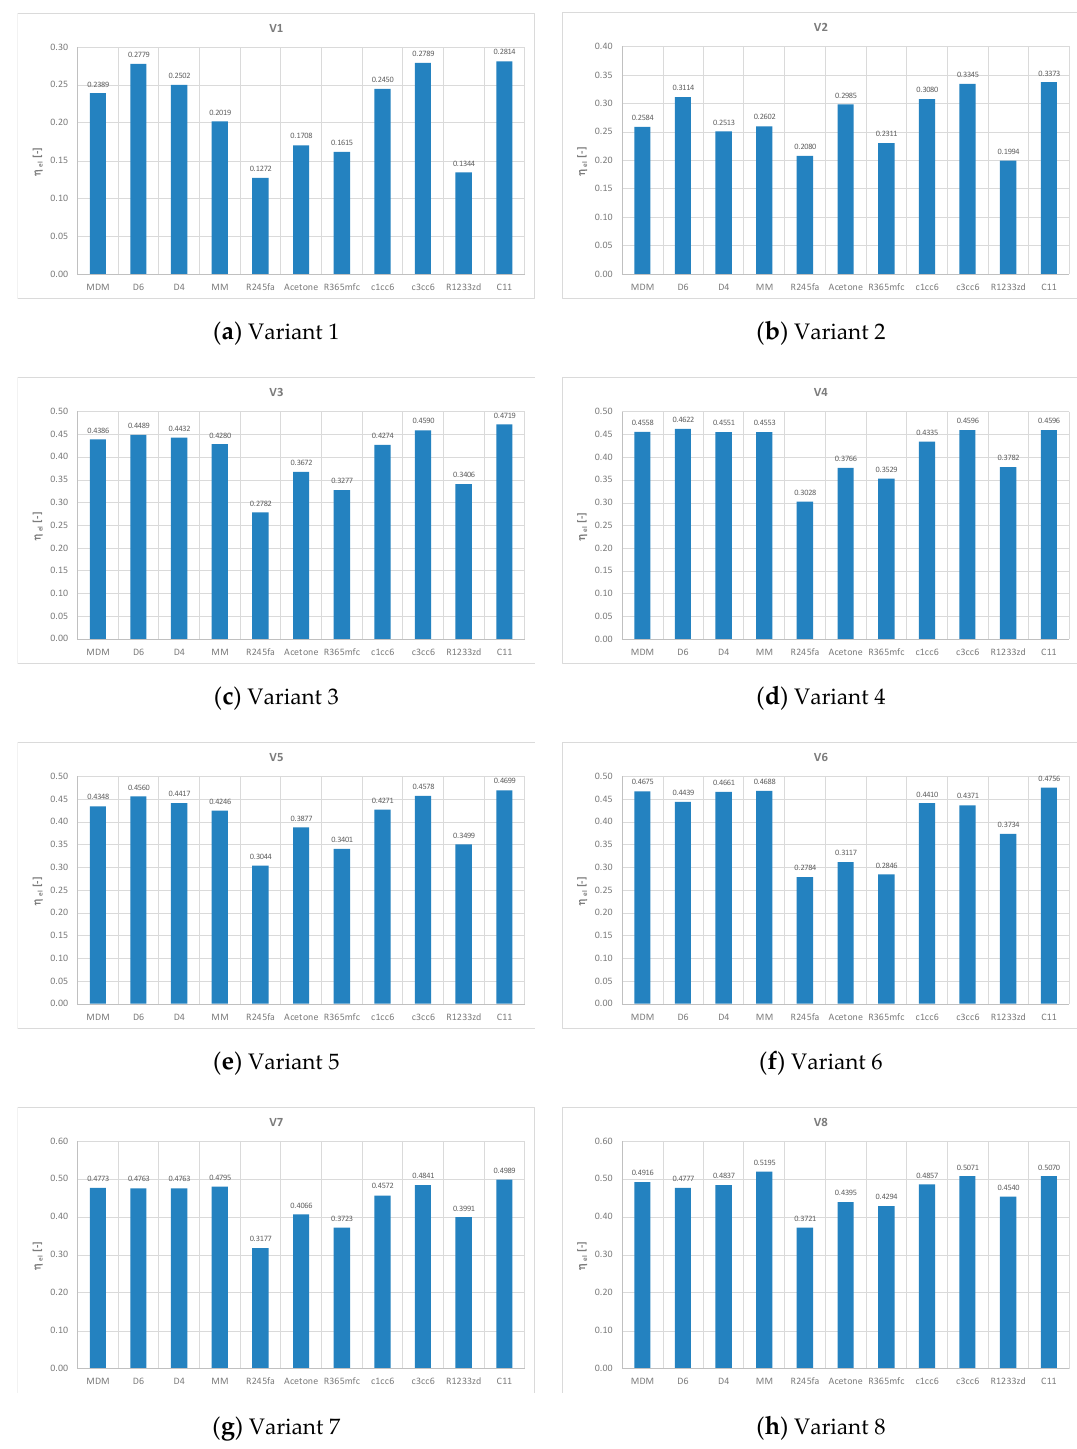
Figure 8. Overall efficiency for different working media: (a) Variant 1; (b) Variant 2; (c) Variant 3; Figure 8. Overall e ffi ciency for di ff erent working media: ( a ) Variant 1; ( b ) Variant 2; ( c ) Variant 3; (d) Variant 4; (e) Variant 5; (f) Variant 6; (g) Variant 7; (h) Variant 8. ( d ) Variant 4; ( e ) Variant 5; ( f ) Variant 6; ( g ) Variant 7; ( h ) Variant